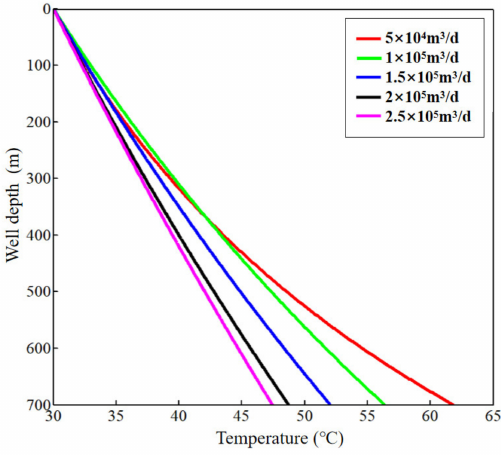
Figure 13. Temperature distribution of spray water under different outputs.